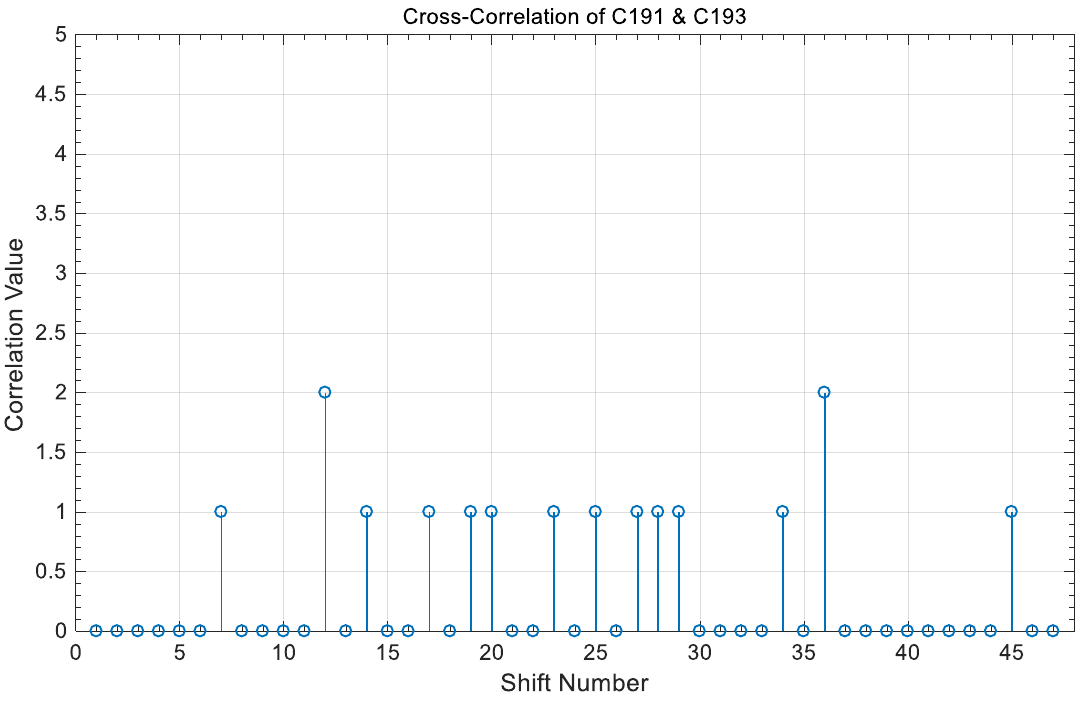
Figure 13. Cross-correlation between 𝐶 191 and 𝐶 193 sequences in same group, 𝑃 1 = 5 and 𝑃 2 = 7 .